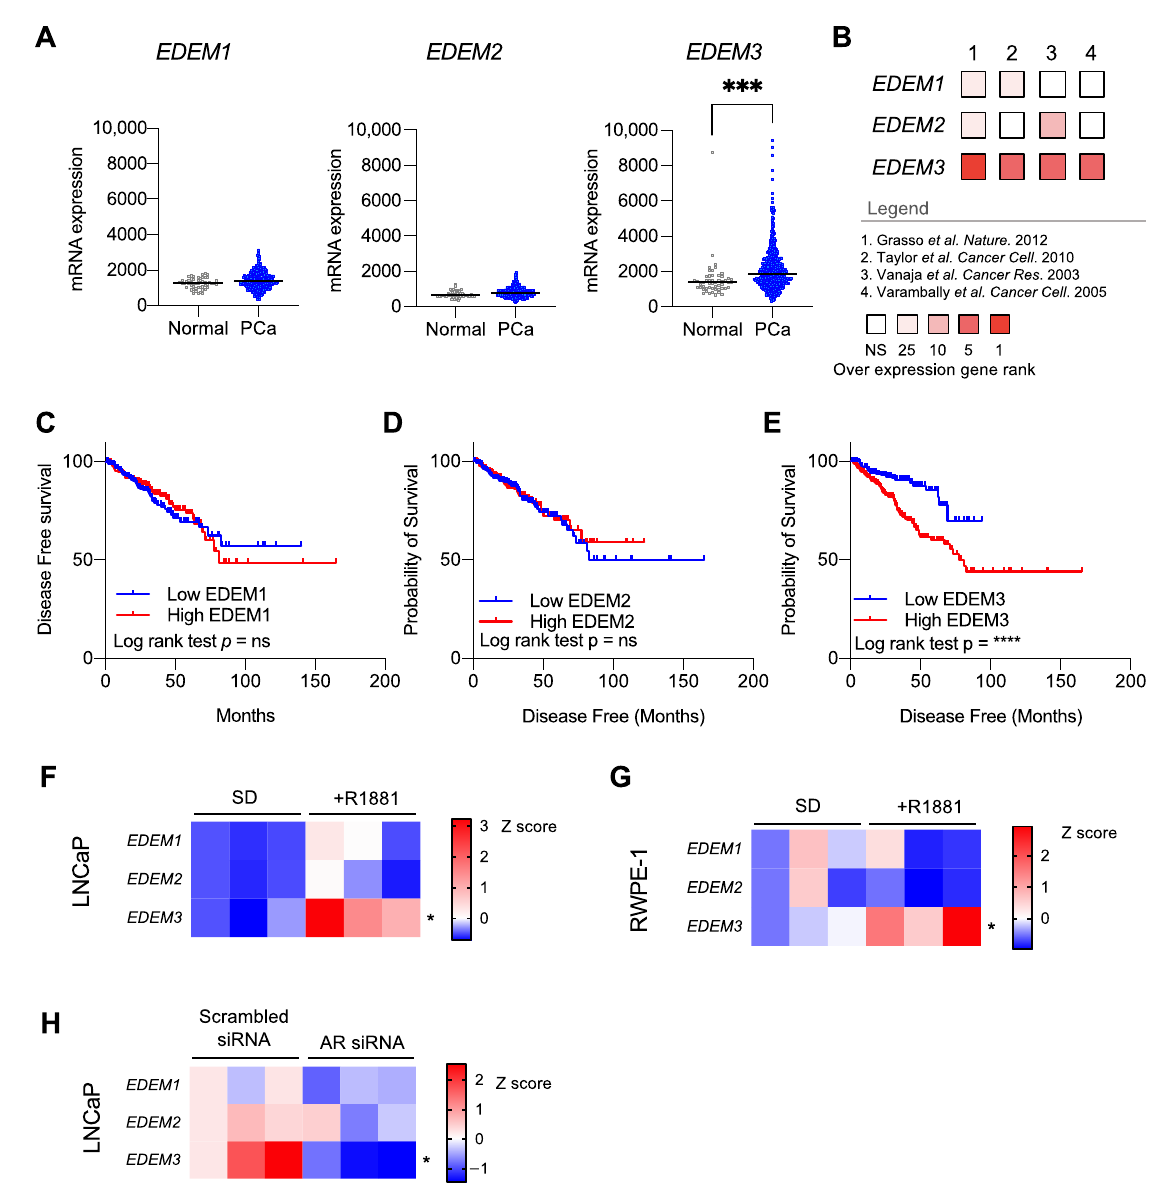
Figure 1. EDEM3 upregulation is associated with a reduced disease-free survival in prostate can- cer (PCa). ( A ) Analysis of EDEM gene expression in The Cancer Genome Atlas (TCGA) prostate adenocarcinoma cohort (n = 497) compared with normal prostate samples (52). ( B ) Meta-analysis of EDEM1/2/3 gene expression in prostate cancer. Four independent prostate cancer gene expression data sets (n = 366) were analysed for EDEM1/2/3 gene expression in prostate cancer patients compared with patients with normal prostates. Data shown are of overexpression gene rank in each dataset. Legend includes details of the independent cohorts. NS = not significant, 25 = top 25%, 10 = top 10%, 5 = top 5% and 1 = top 1%. Data accessed using Oncomine [29–32]. ( C – E ) Kaplan–Meier plot showing disease-free survival for prostate cancer patients stratified based on low (bottom 50%) or high (top 50%) EDEM3 expression. Analysis includes 471 prostate cancer patients from TCGA PRAD cohort, accessed via CBioPortal. p value was calculated by log rank test. ( F , G ) Heatmaps showing mRNA levels of EDEM1/2/3 in both LNCaP and RWPE-1 cultured in either steroid-depleted (SD) conditions or stimulated with 10 nM R1881 for 24 h. n = 3 and data are presented as z-scores. ( H ) Heatmap showing mRNA levels of EDEM1/2/3 in LNCaP cells following androgen receptor siRNA knockdown, compared with scrambled siRNA control. n = 3 and data are shown as z-scores. p values were calculated using a two-tailed unpaired t -test. * p < 0.05, *** p < 0.001, **** p < 0.0001.